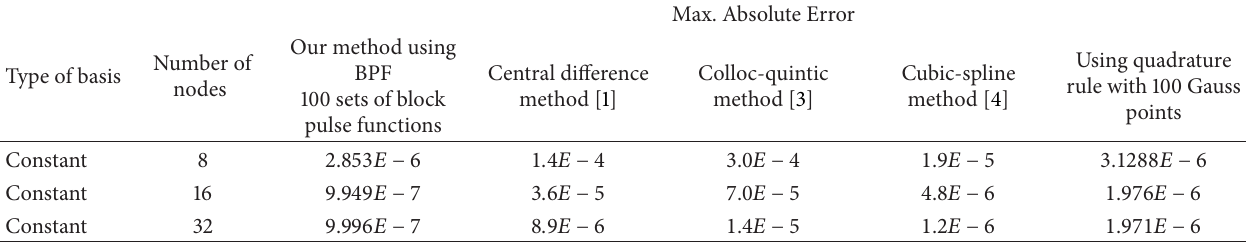
Table 1: Observed maximum errors for Problem 1, using BPF (25).